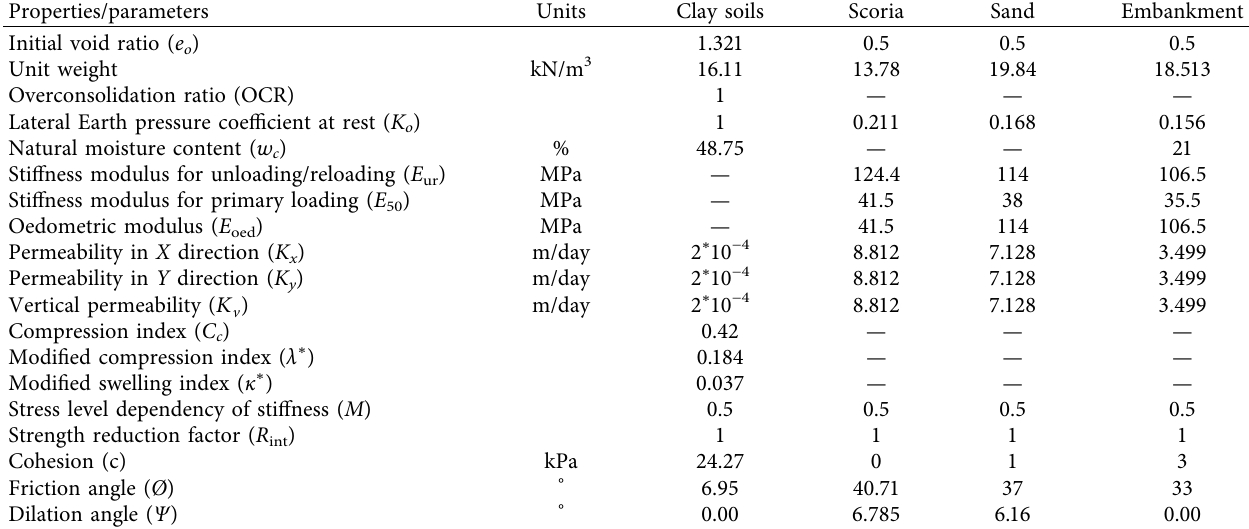
Table 3: Input parameters used for the numerical